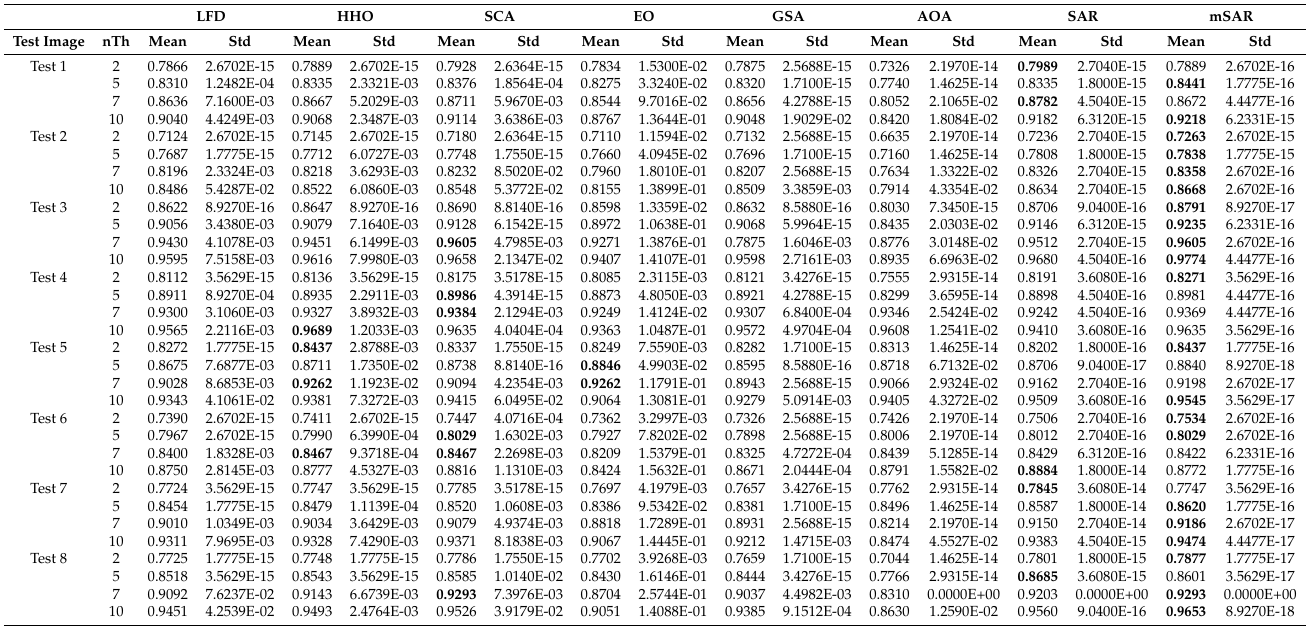
Table 7. mSAR fuzzy entropy in terms of FSIM values over all competed